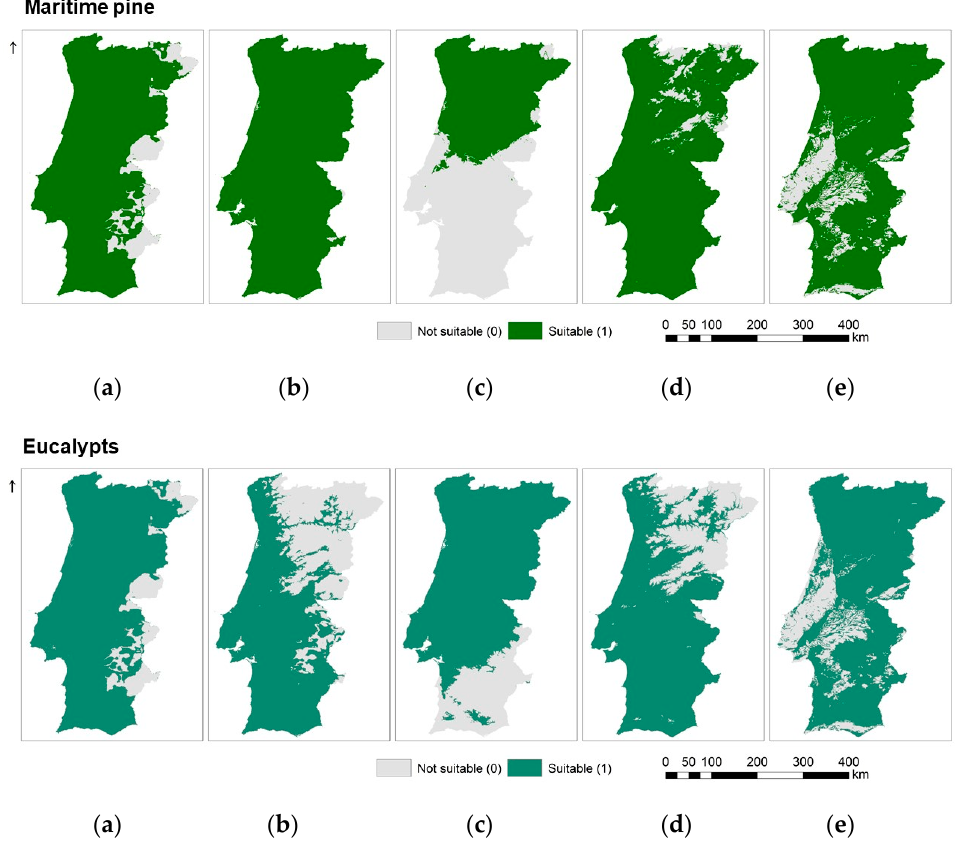
Figure 3. Species ecological envelopes input variables (1960–1990) Boolean maps (0—Not suitable,